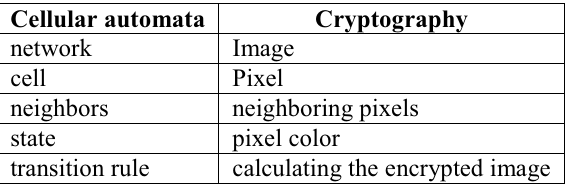
Table 1. Correspondence between cellular automata and cryptography according to